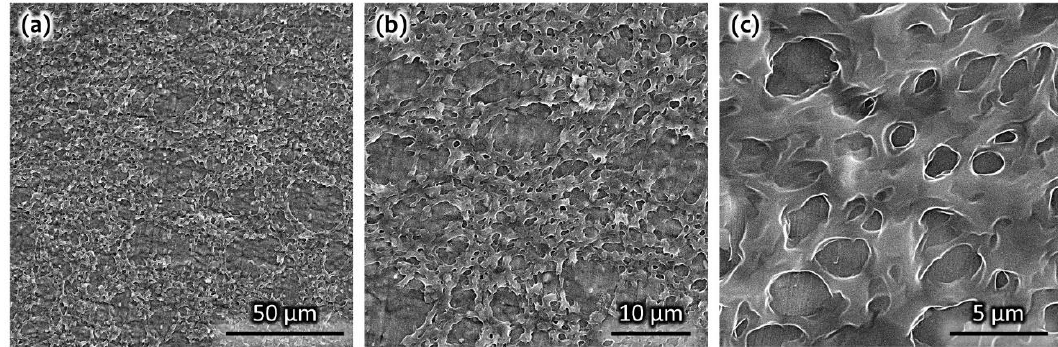
Figure 2. Scanning electron microscopy (SEM) images of polyvinyl acetate film with different magnifications ( a ) 500×, ( b ) 1000×, and ( c ) 5000×.